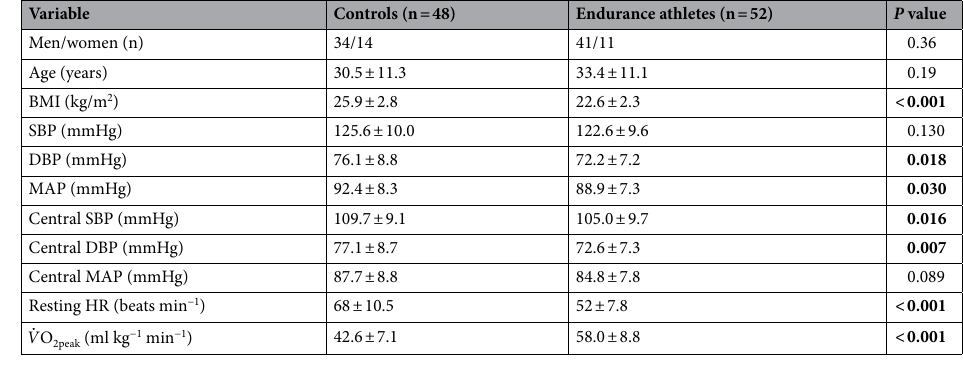
Table 1. Characteristics of endurance athletes and controls. Data are expressed as mean ± standard deviation from two-tailed independent samples t -tests or Mann–Whitney U-tests, with P -values below 0.05 bolded. Variances were equal between groups for all variables except for resting HR. BMI, body mass index; SBP, systolic blood pressure; DBP, diastolic blood pressure; HR, resting heart rate; (cardiorespiratory)